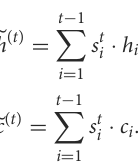
h ( t − 1) used in Equations (2)–(4) by a cell and hidden memory